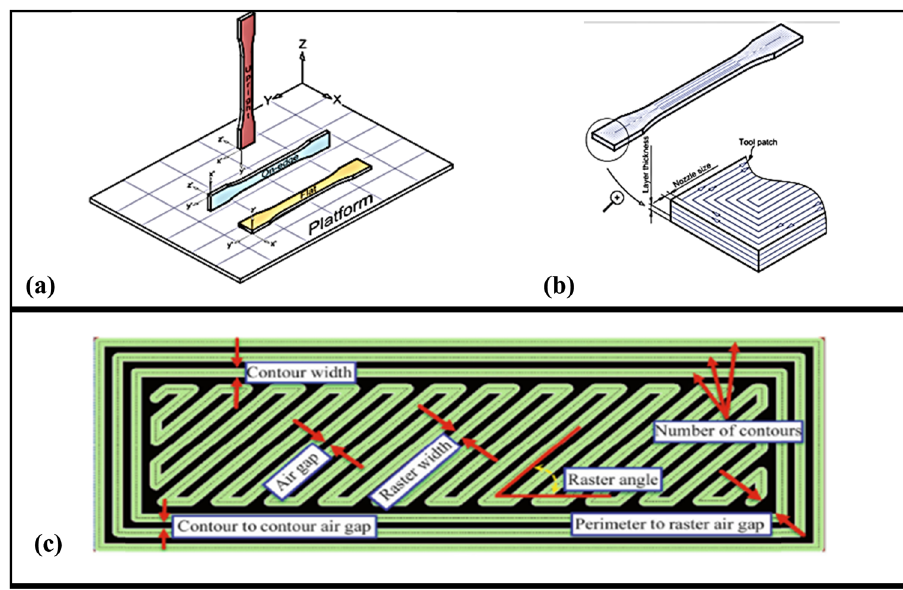
Figure 3: ( a ) Build orientations [ 9 ] , ( b ) layer thickness [ 9 ] , and ( c ) FDM tool path parameters [ 52 ]